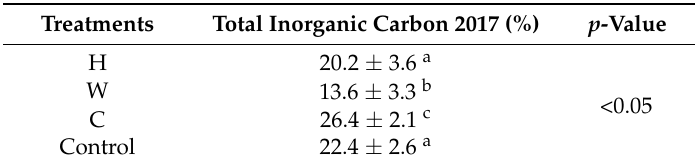
Table 12. Results of the ANOVA and Tukey test for inorganic carbon (df 3, 24; average ± SD), difference tested between soil of harvested area and